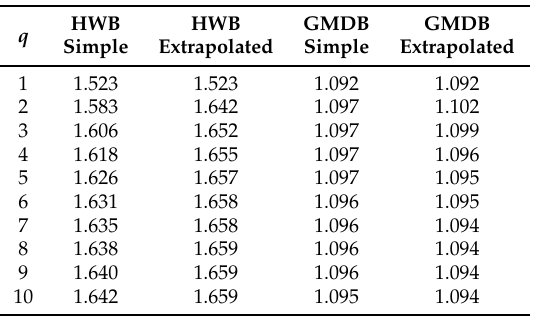
Table 6. Erlangized price